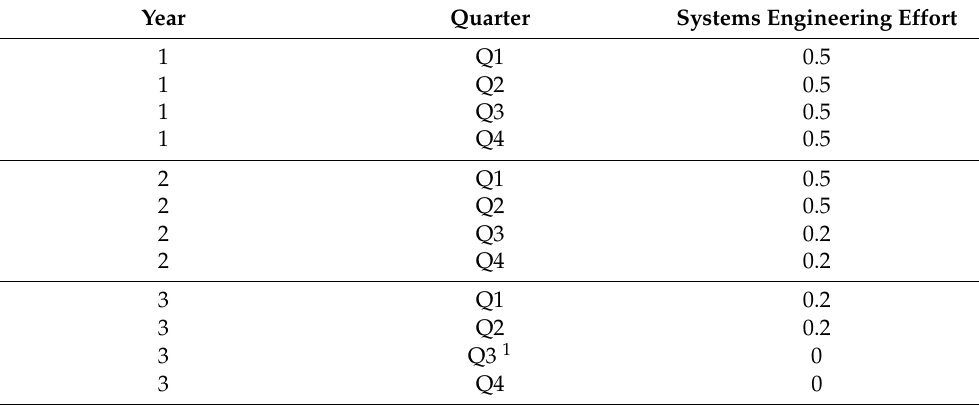
Table 6. Initially estimated systems engineering effort for the cybersecurity design of the V2G gateway